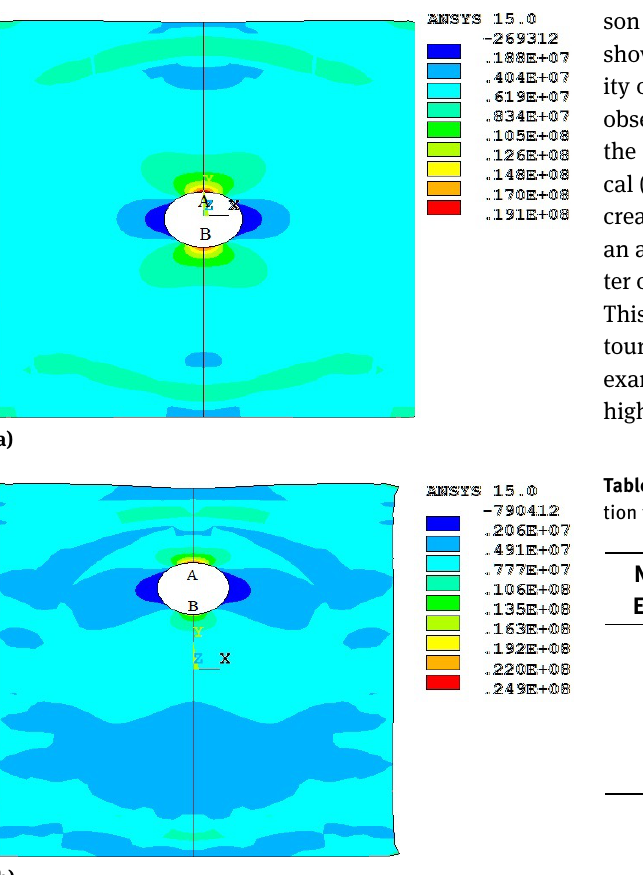
Figure 9: Schematic diagram of hole eccentricity with respect to loading direction ( i.e. , x-axis)